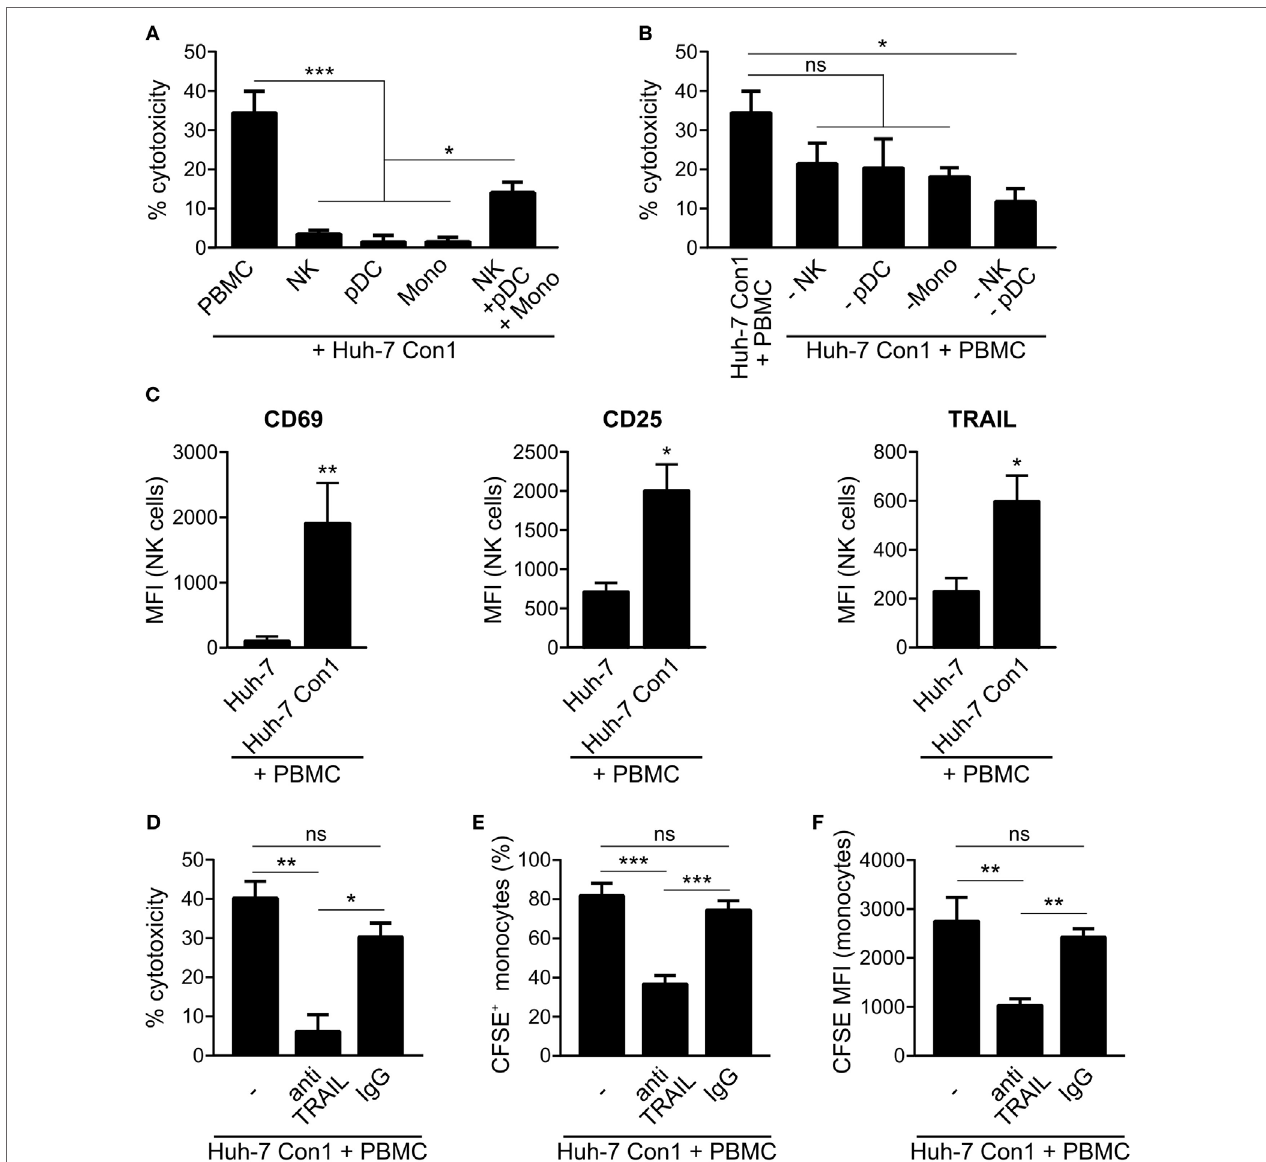
FigUre 6 | Killing of hepatitis C virus subgenomic replicon cells requires interaction of innate immune cells. (a) Huh-7 Con1 cells were co-cultured with peripheral blood mononuclear cells (PBMCs), purified immune cells [natural killer (NK), plasmacytoid dendritic cells (pDC), or Monocytes (Mono)] or with a recombination of purified NK cells, pDCs and monocytes (NK + pDC + Mono) overnight. Supernatants were collected and measured for lactate dehydrogenase (LDH) activity ( n = 3). (B) Huh-7 Con1 cells were co-cultured with PBMCs, PBMCs depleted from NK cells (-NK), from pDCs (-pDC), from monocytes (-Mono), or from NK cells and pDCs (-NK -pDC) overnight. Supernatants were collected and measured for LDH activity ( n = 4). (c) Huh-7 cells were co-cultured with PBMCs overnight. NK cell (CD56 + , CD3 − ) expression of CD69, CD25, and TRAIL was analyzed by flow cytometry ( n = 4). (D–F) Huh-7 Con1 cells were co-cultured with PBMCs in the presence of an anti-TRAIL antibody or an IgG control antibody (each 10 µg/ml) overnight. LDH release was measured in the supernatant (D) , percentage of CFSE + monocytes (e) , and carboxyfluorescein succinimidyl ester (CFSE) mean fluorescence intensity (MFI) of monocytes (F) was determined ( n =